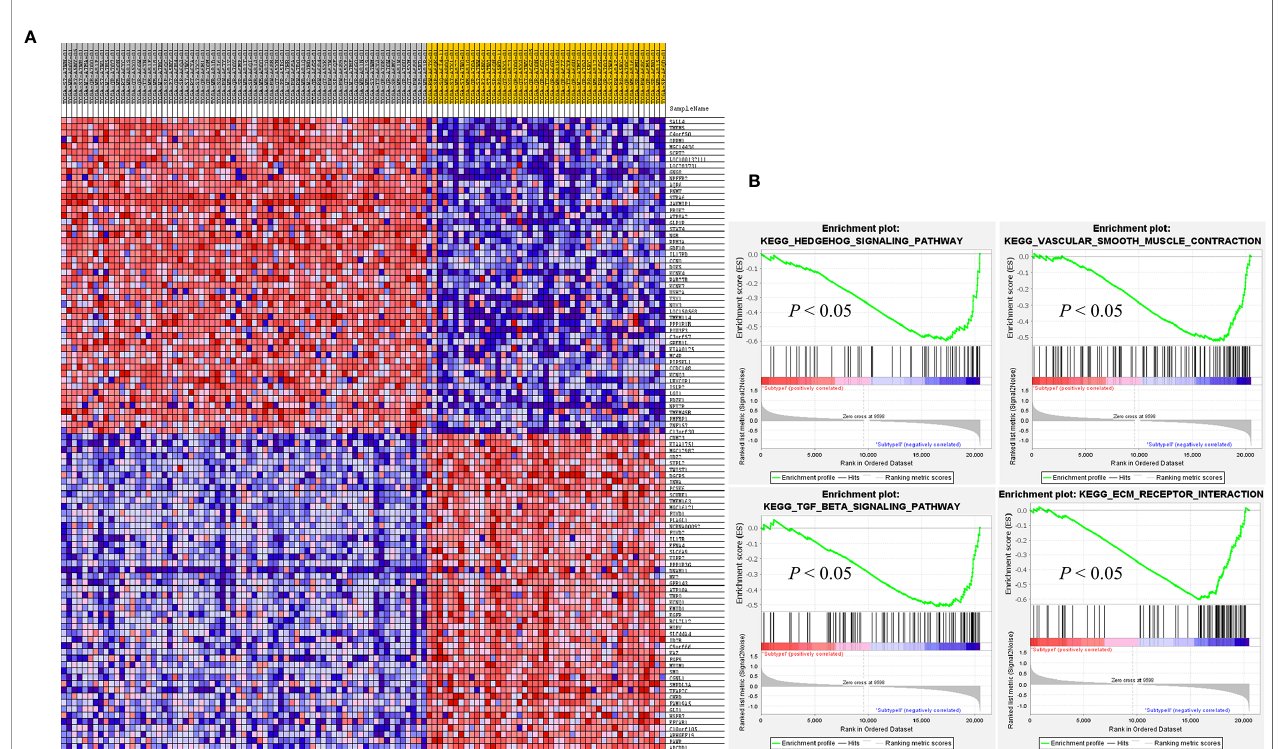
FIGURE 5 | GSEA results validates the different gene expression patterns found in each PCC subtype. (A) Heatmap of gene expression of Top 100 genes in subtype I and subtype II. Over-expressed genes (Red) and down-expressed genes (blue). (B) GSEA enriched pathways in subtype II. GSEA results presented improved expression of vascular smooth muscle contraction and hedgehog signaling pathway. Distinct gene expression signatures are produced by the individual gene sets enriched in subtype I and subtype II. Permutation = 1000, p < 0.01